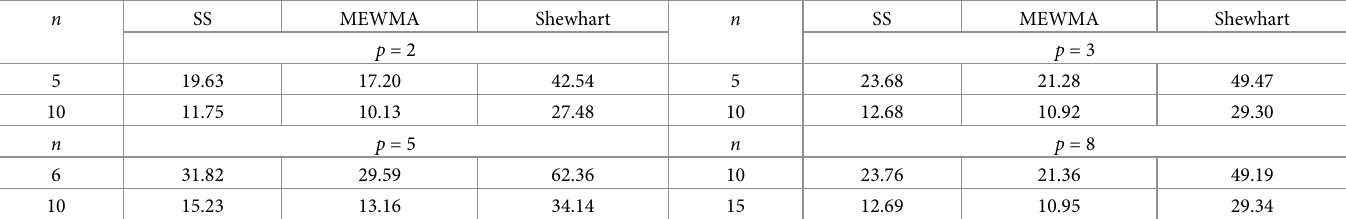
Table 8. A comparison of the EARL of the multivariate SS chart with the MEWMA and Shewhart γ charts for γ 0 = 0.10, p 2 {2,3,5,8} and n 2 {5,6,10,15}, where ( τ min , τ max ) =